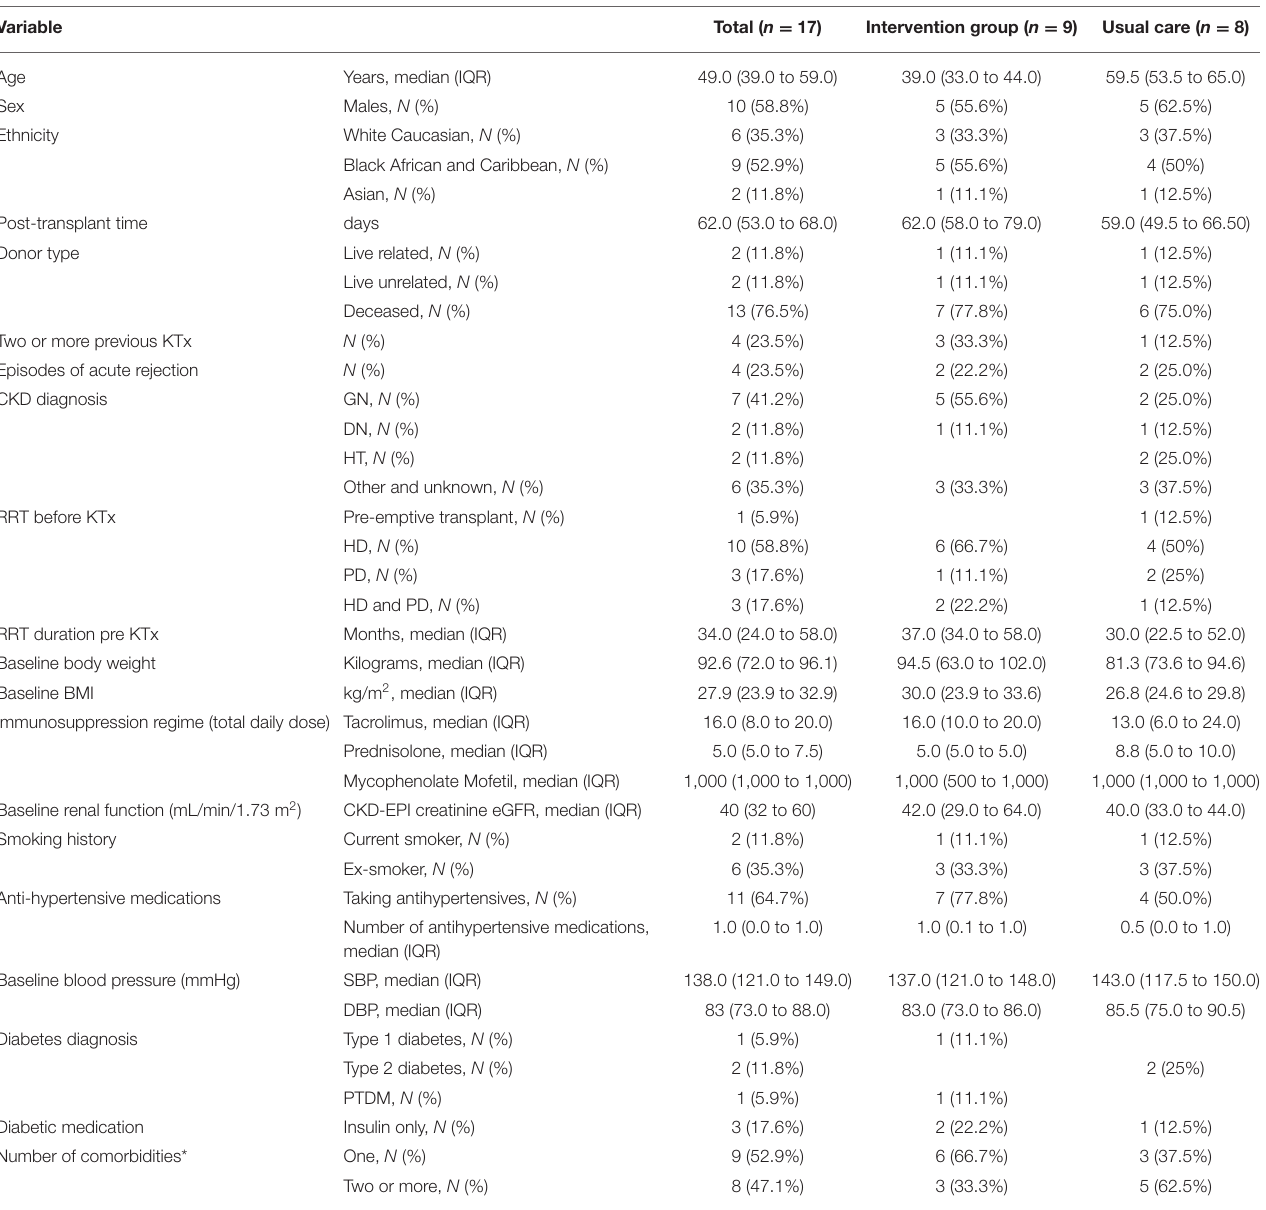
TABLE 2 | Participant characteristics at